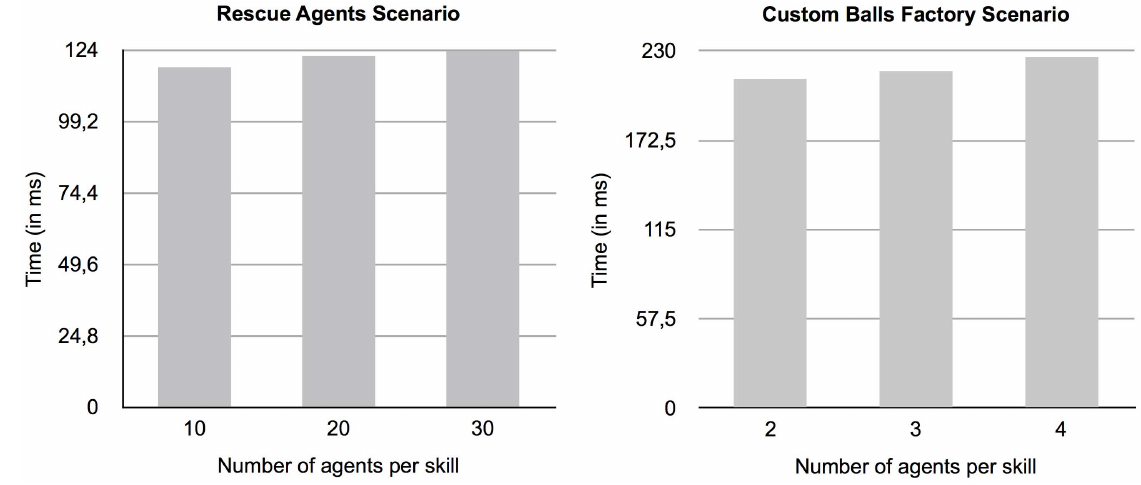
Figure 4. Comparison of time to generate the semanticoverlaynetwork as the number of agents per skill varies.